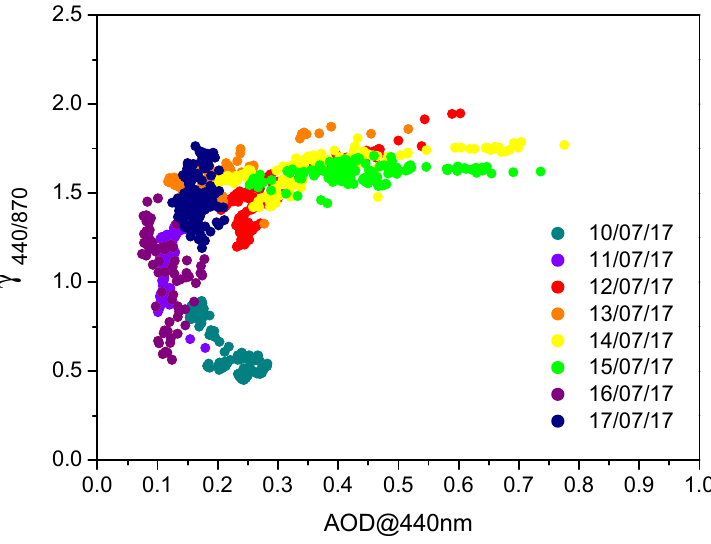
Figure 8. AOD vs. γ derived from AERONET data corresponding to 10–17 July 2017 period. Volume particle size distribution dV(r)/dln(r) derived from the AERONET hybrid inversion data procedure were also analyzed to highlight any difference in the aerosol composition. A representative particle size distribution was obtained by averaging over 24 hours the different size distributions obtained during the day. Figure 9 reports the columnar size distributions dV(r)/dln(r) for the period 10–15 of July; data for 16 and 17 of July are missing. The error bars of the data points in Figure 9 represent the uncertainty calculated as the mean standard deviation. This analysis highlights an interesting variation of the atmospheric aerosol composition during the days affected by fire events, showing a reduction in coarse mode aerosol components together with a larger predominance of fine particulates. According to Saharan dust transport events, a larger contribution of coarse mode fraction aerosol was present on 10 July, whereas on 12 July, a fine aerosol contribution was added to a similar content of coarse mode aerosol due to Saharan dust mixing with biomass burning aerosol. It is worth noticing the shift and increase in the peak value of the fine mode components for 13–15 July as a consequence of the arrival of biomass burning aerosols in the measurement